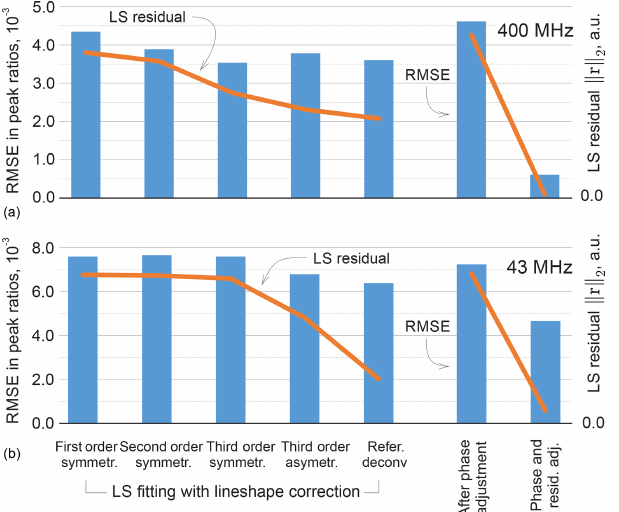
Figure 11. Results of LS fitting of high-field (a) and medium- field (b) data using models that take into account higher-order line- shape distortions. From left to right: first-order Lorenzian, second- order symmetric model (weighted combination of Lorentzian and Gaussian lineshapes), and third-order symmetric and asymmetric peak models. In the reference deconvolution approach, a single ker- nel is estimated for all peaks based on the difference between the experimental spectrum and a fitted Lorentzian model. For the pro- posed method, the results are reported after the phase adjustment (Eq. 8) and the final distribution of the residual (Eq. 6) on the right- hand side of the figure. The RMSE in peak ratios are indicated with blue bars and referenced to the right vertical axis; the norms of the residual after the least-squares fitting are plotted with orange lines and are expressed in arbitrary units. Note that lower norms of the residual achieved by fitting more flexible models to the data do not always entail reduced quantification errors, whereas the proposed adjustment method achieves this goal more efficiently, especially for high-field (400MHz) data.